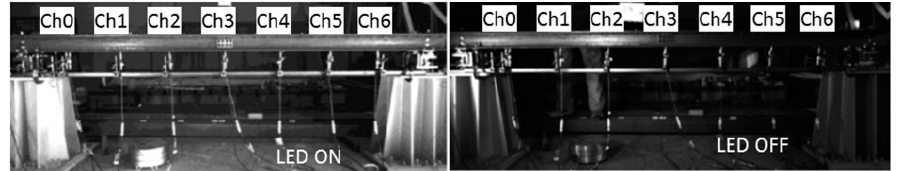
Figure 15. Calculation result of the feasibility rate according to the camera distance and span length.